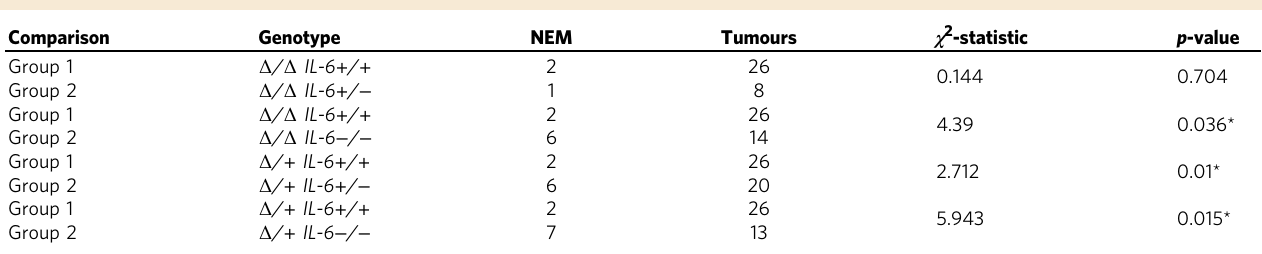
Table 1 Loss of IL-6 in Δ 122p53 mice reduces tumour incidence